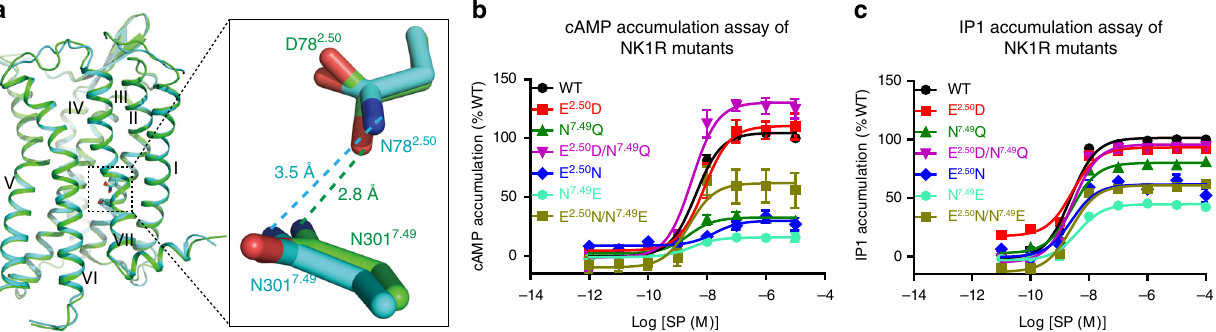
Fig. 3 Interaction modes of the residues at positions 2.50 and 7.49 and functional assays of NK1R mutants. a Strong hydrogen-bond interaction between D78 2.50 and N301 7.49 (2.8 Å) and weak interaction between N78 2.50 and N301 7.49 (3.5 Å). Two NK1R structures are shown in cartoon representation and colored green (E78 2.50 D mutant) and cyan (E78 2.50 N mutant). The residues at positions 2.50 and 7.49 are shown as sticks. b SP-induced cAMP accumulation measurements of the wild-type (WT) NK1R and the mutants E78 2.50 D, N301 7.49 Q, E78 2.50 D/N301 7.49 Q, E78 2.50 N, N301 7.49 E, and E78 2.50 N/N301 7.49 E. Dose – response curves were generated from at least three independent experiments performed in triplicate. Data shown are mean ± s.e.m. See Supplementary Table 3 for detailed statistical evaluation. c SP-induced IP1 accumulation of the WT NK1R and the mutants E78 2.50 D, N301 7.49 Q, E78 2.50 D/N301 7.49 Q, E78 2.50 N, N301 7.49 E, and E78 2.50 N/N301 7.49 E. Dose – response curves were generated from at least three independent experiments performed in triplicate or duplicate. Data shown are mean ± s.e.m. See Supplementary Table 2 for detailed statistical evaluation. Source data for Fig. 3b,